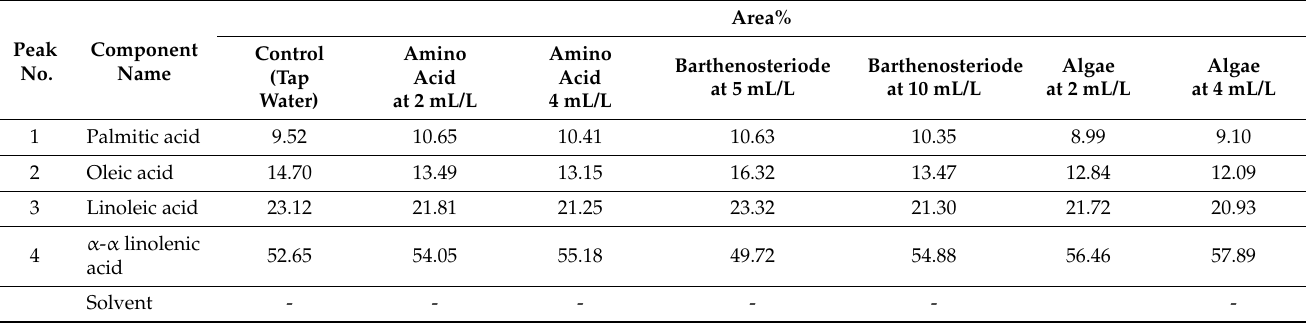
Table 6. Effect of different treatments on the fractions of fixed oil contents of chia (Salvia hispanica L.) plants during the second season (2020–2021).